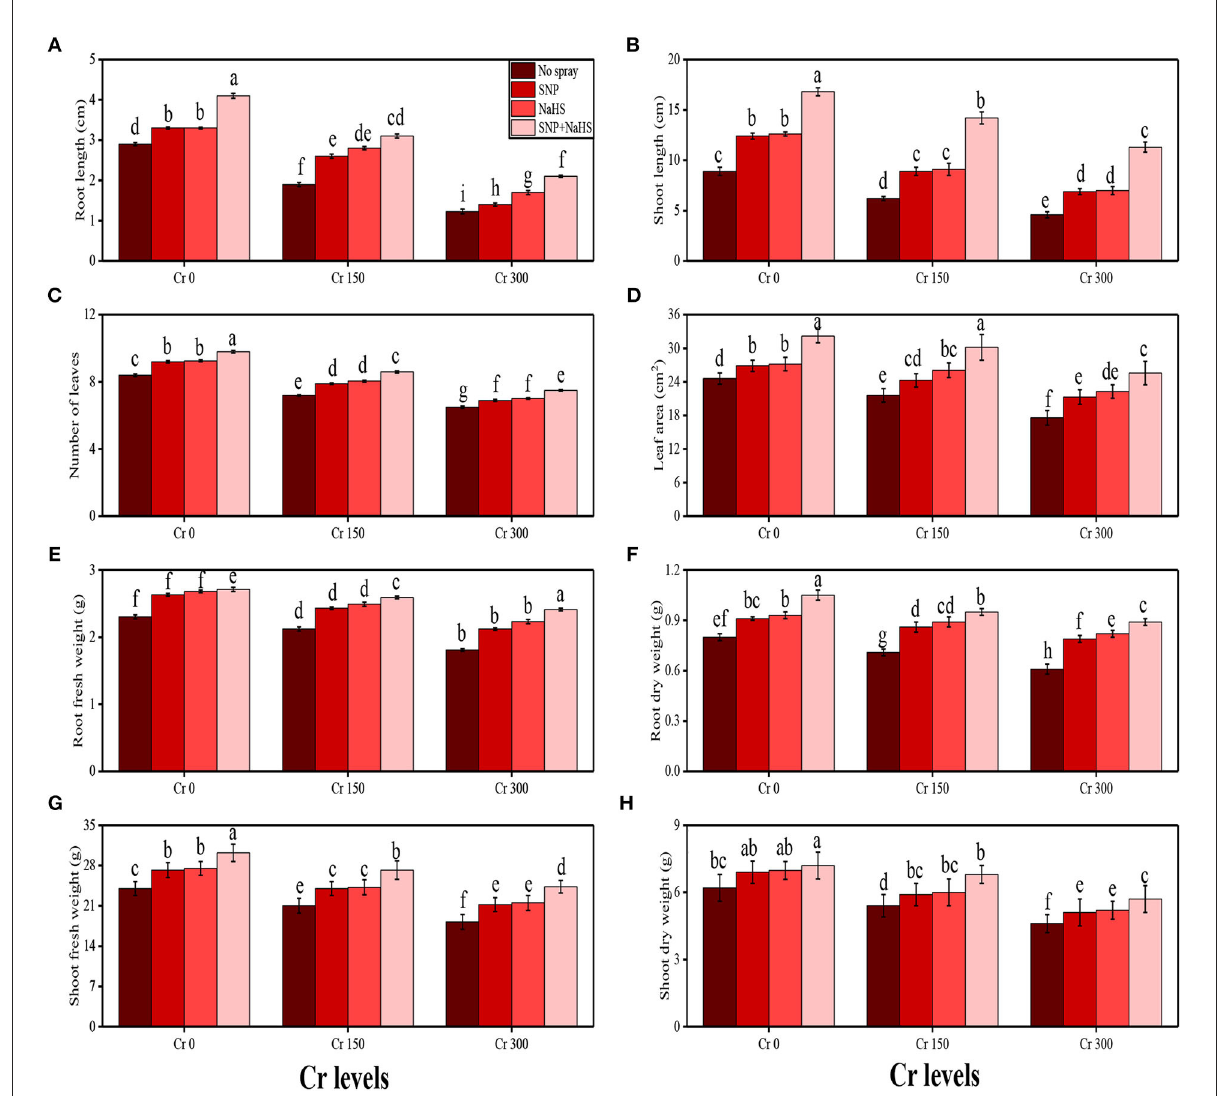
FIGURE1 Impact of individual and combinatorial application of SNP and NaHS on growth attributes, i.e., (A) root length, (B) shoot length, (C) number of leaves, (D) leaf area, (E) root fresh weight, (F) root dry weight, (G) shoot fresh weight, and (H) shoot dry weight of spinach ( S. oleracea ) plants grown under different levels of Cr [0 (no Cr), 150, and 300 µ M] in sandy loam soil. Values in the figures indicate just one harvest. Mean ± SD ( n = 4). Two-way ANOVA was performed and mean differences were tested by HSD ( P < 0.05). Different lowercase letters on the error bars indicate significant differences between the